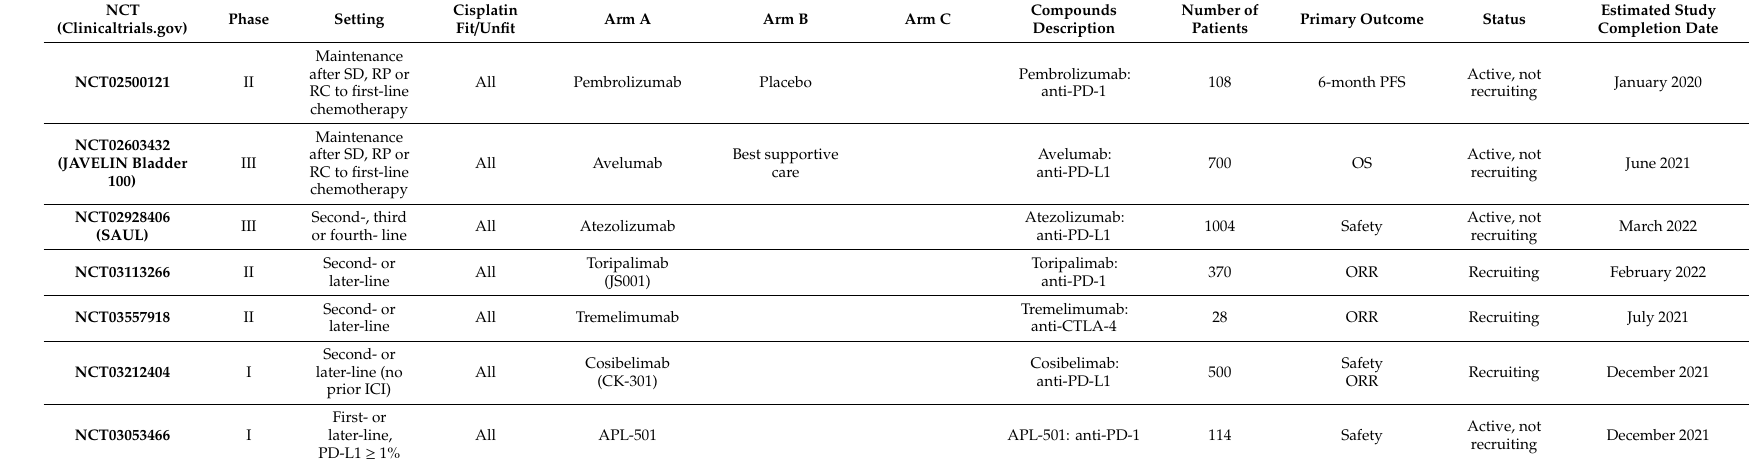
Table 4. Ongoing phase I / II / III trials of monotherapy immune checkpoint inhibitors. ORR: overall response rate. PFS: progression-free survival. OS: overall survival. NCT